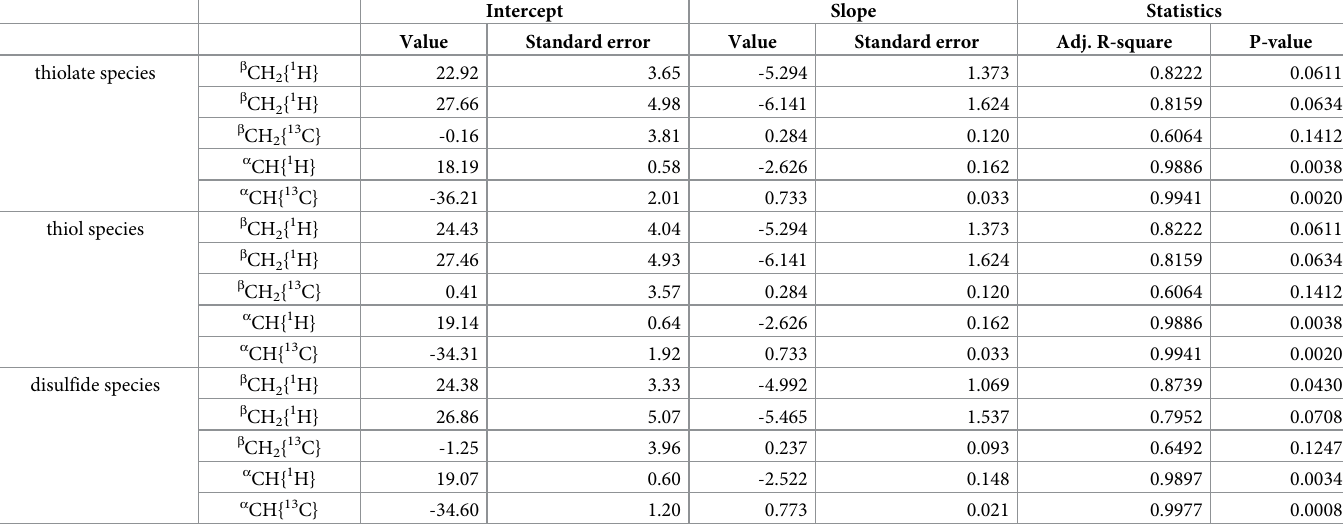
Table 2. The regression statistics of the cysteine and cystine chemical shift